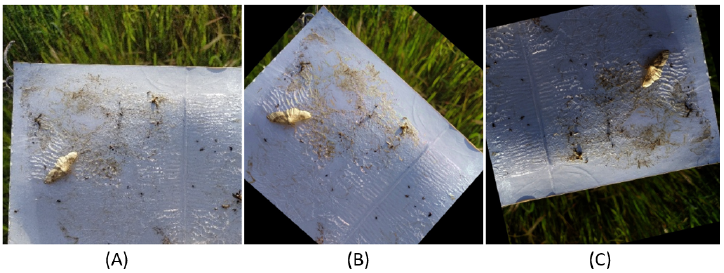
Figure 5. Examples of data augmentation: ( A ) original patch image; ( B , C ) random brightness, saturation, contrast, and rotation